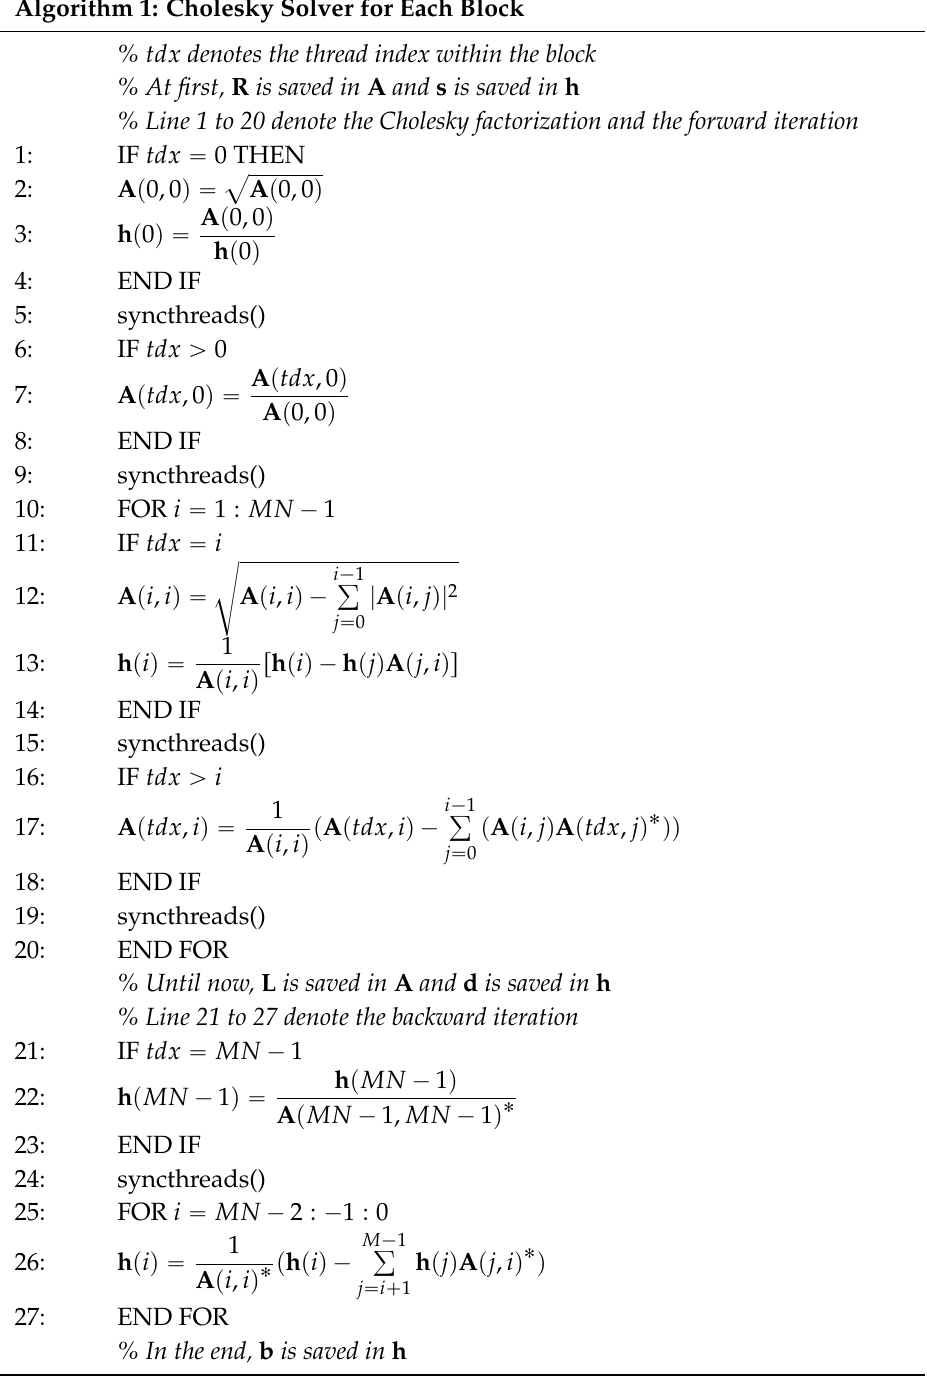
Algorithm 1: Cholesky Solver for Each